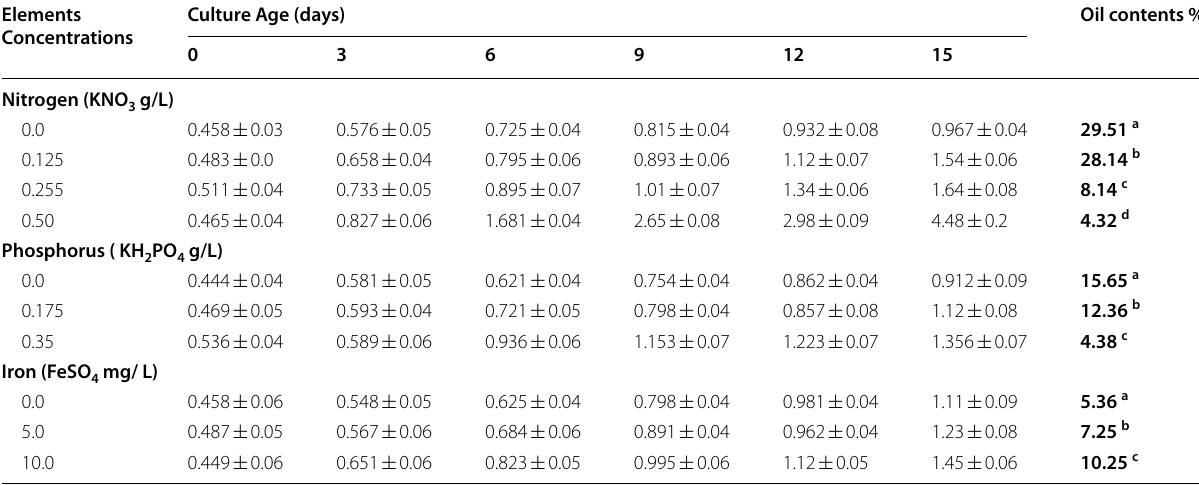
Data represent means SD values from three independent experiments. The Values of the all parameters [Dry weight (g/L), Chll a (mg/L), Oil content (%) and Oil Yield ± (g/L)] in the column are significantly different at < 0.05 The different letters in the same column are significant differences between the treated samples